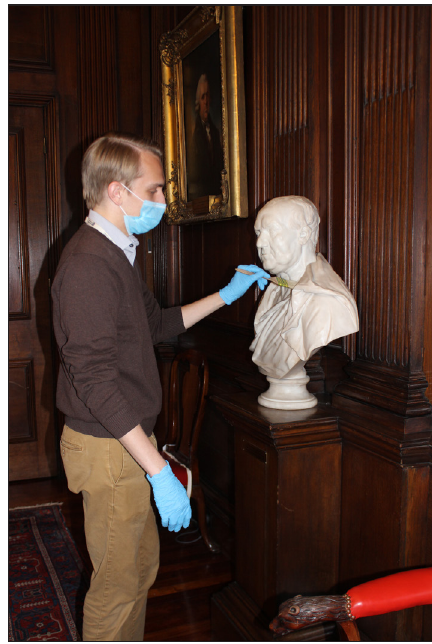
Figure 4: Zachary Veith carrying our preven- tative conservation on marble busts during his internship at the Royal College of Physi- cians (Photo: Lowri